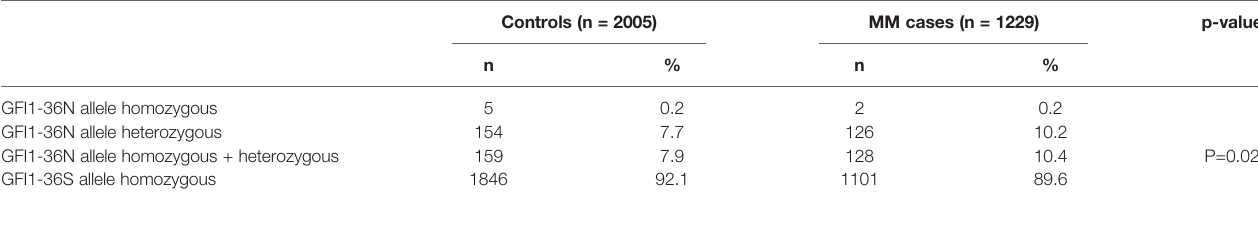
TABLE 1 | The frequency of the GFI1-36N allele was determined within a population of newly diagnosed MM patients and a respective control population. OR 1.35, 95%CI 1.06-1.72.